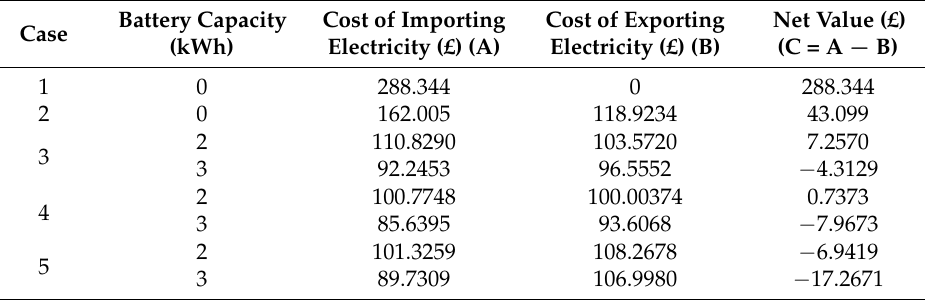
Figure 10. Imported and exported power with a PV system, grid, and BSS operated during on- and off-peak hours. Table 1. Cost analysis of the cases 1, 2, 3, 4, and 5.